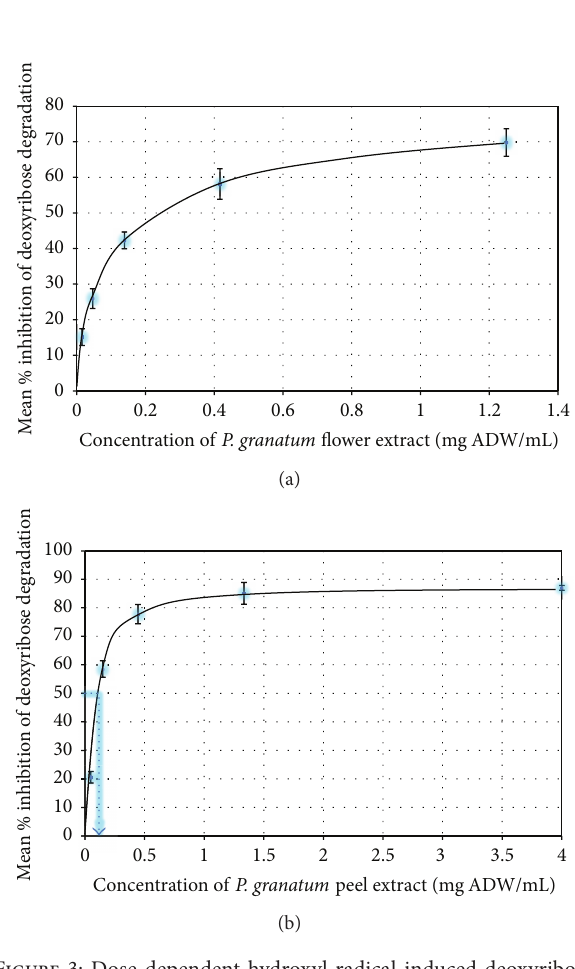
Figure 3: Dose-dependent hydroxyl radical induced deoxyribose degradation inhibition by pomegranate flower and peel extracts. ADW: air dry weight; data are representative of mean ± standard deviation of three replicates. IC 50 values were extrapolated from the